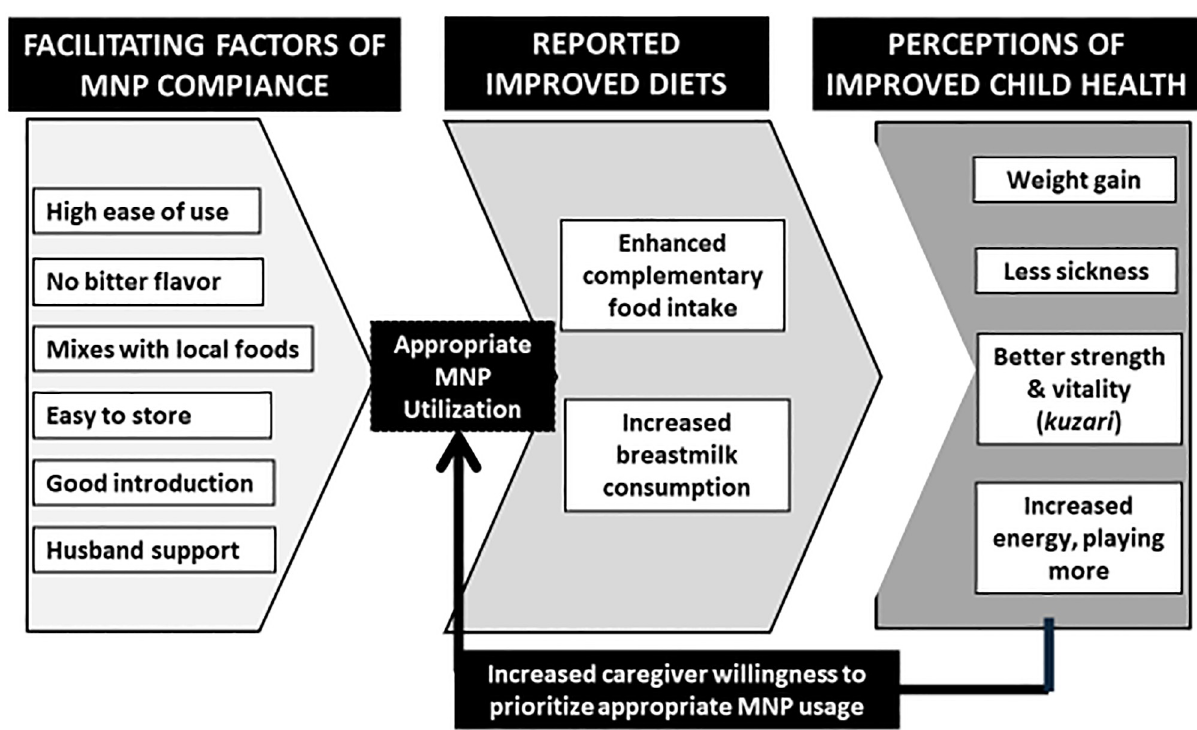
Fig 1. Facilitating factors of micronutrient powder (MNP) compliance. Six facilitating factors emerged from spot check and interview data related to MNP acceptance and compliance: high ease of use, “no bitter flavor,” mixes with local foods, easy to store MNP,” good introduction,” and husband support.